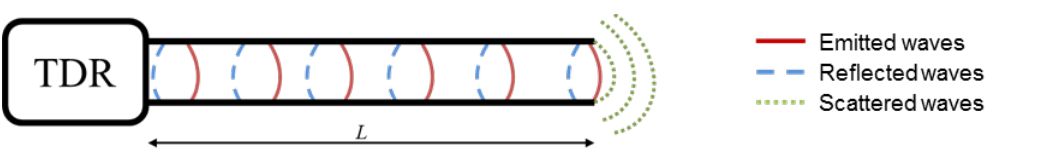
Figure 1. Operating principle of a TDR (Time-Domain Reflectometry)